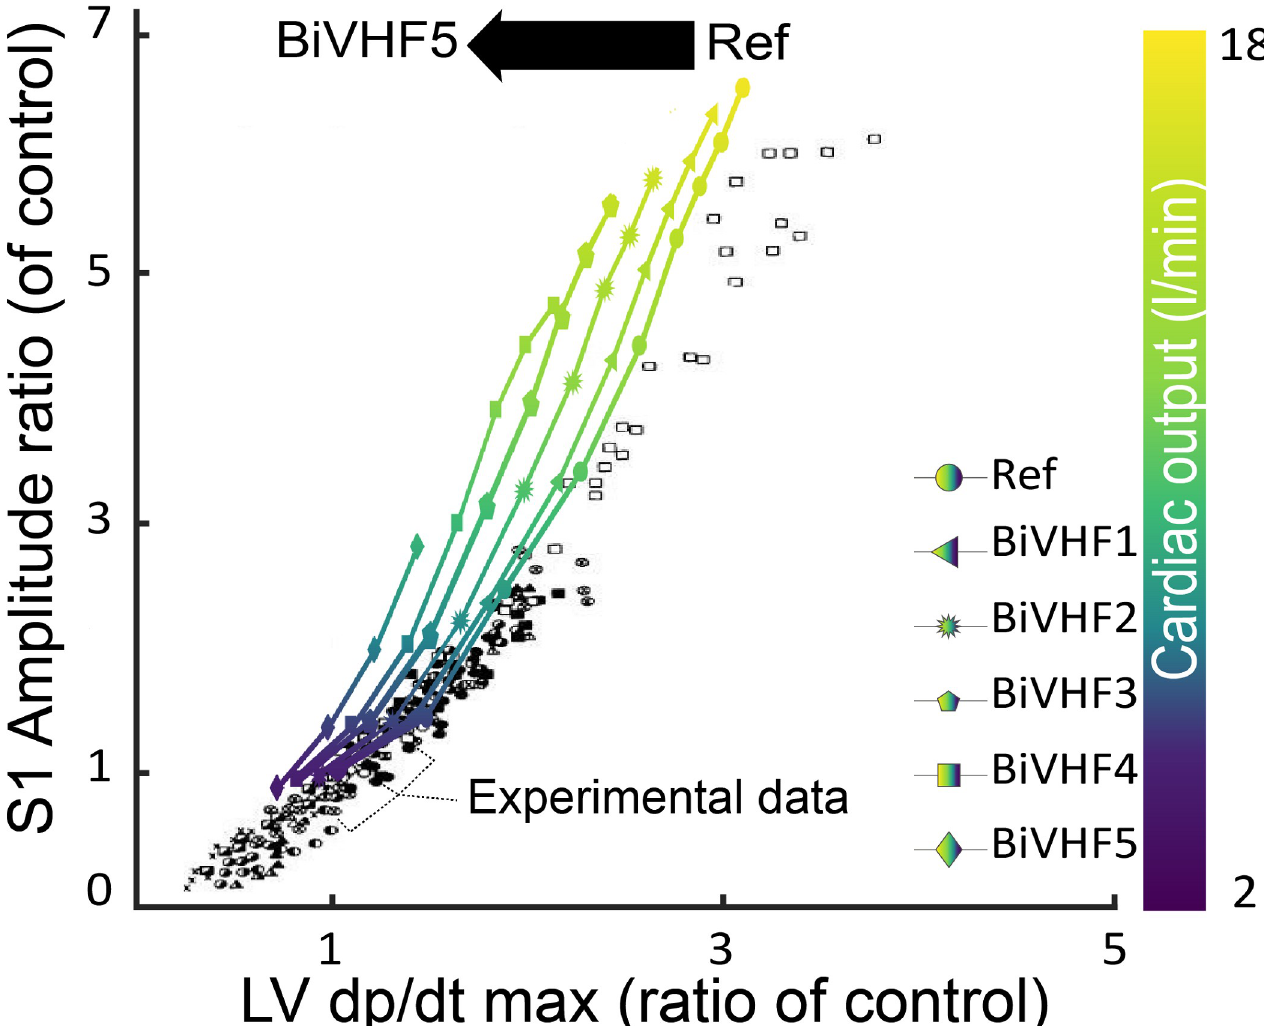
Fig 6. Relation between LV dp/dt max and the first heart sound amplitude in simulations and reported experimental observations [26]. Conditions used in the experiment are: Aortic insufficiency, Aortic occlusion, Atropine, Artery occlusion, Epinephrine, Haemorrhage, Histamine, Isoprenaline, Methoxamine, Myocardial infarction, Norepinephrine, Phenylephrine, Pulmonary Rapid saline infusion, Pitressin, Veratridine, Venae cavae occlusion. BiVHF1-5 : biventricular heart failure levels, LV dp/dt max: maximum of first derivative of left ventricular pressure, Ref : reference.